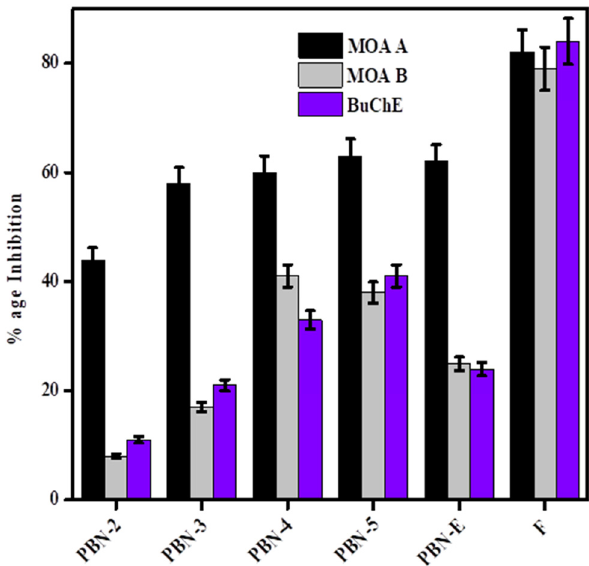
Figure 7: Enzyme inhibition potential of the extract, extract - loaded nano fi bers, and positive control ( F )